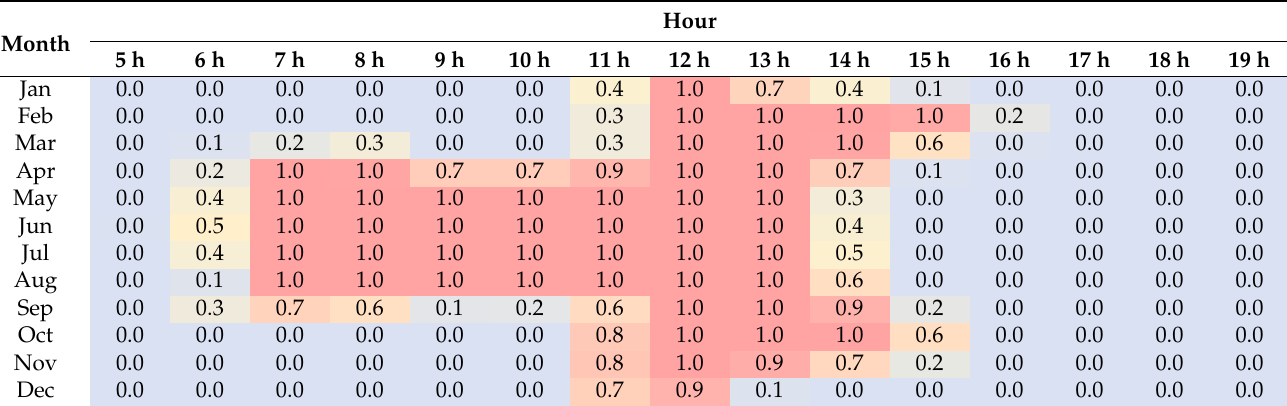
Table A2. Example of month-by-hour (from 5 to 19 h) shading matrix (generated from Figure 5a). As the shading factor increases (becoming red), the degree to which the sky is obscured by shading obstructions